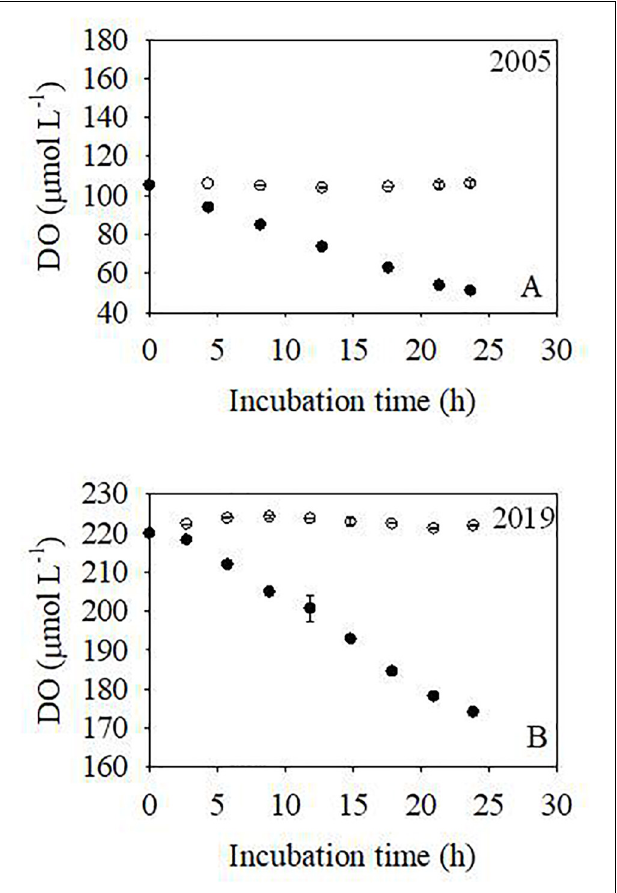
FIGURE 7 | Evolution of DO concentration during the incubations at the upstream-most station (Guangzhou). The solid circles are the samples without HgCl 2 addition; the open circles are the controls (samples with HgCl 2 added). Legends are the same for both panels. 2008 ) .